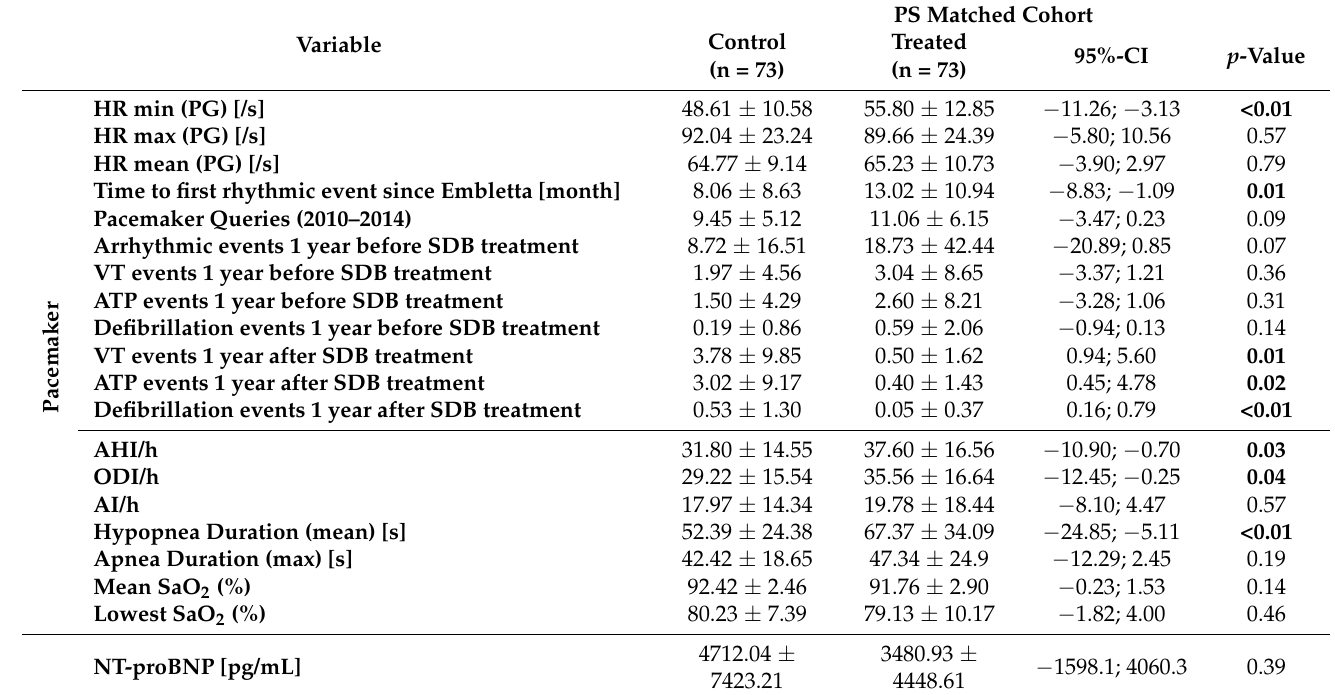
Table 2. Device Interrogation and Multichannel Cardiorespiratory Polygraphy Analysis of the Control and SDB-Treated Patients in the PS Matched